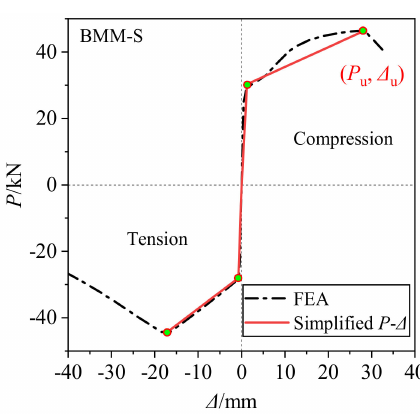
Figure 29. P - ∆ relationship of BMM-S.